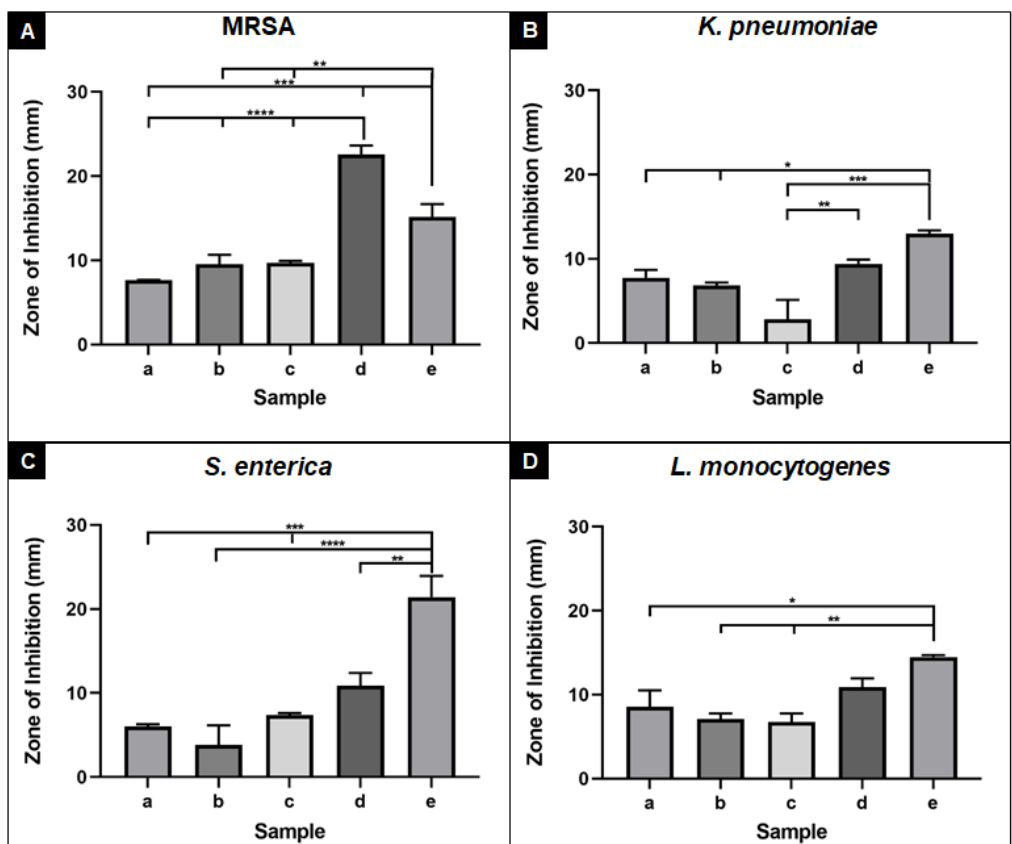
Figure 11. Antimicrobial efficacy of (a) with OEO (2%) before crosslinking, (b) with OEO (2%) after crosslinking, (c) with OEO (3%) crosslinked after water soak, (d) with additional OEO, (e) OEO control against ( A ) MRSA, ( B ) K. pneumoniae , ( C ) S. enterica , and ( D ) L. monocytogenes . Error bars represent standard error of the mean of n = 3 biological replicates. **** p ≤ 0.0001, *** p ≤ 0.001, ** p ≤ 0.01, * p ≤ 0.05.